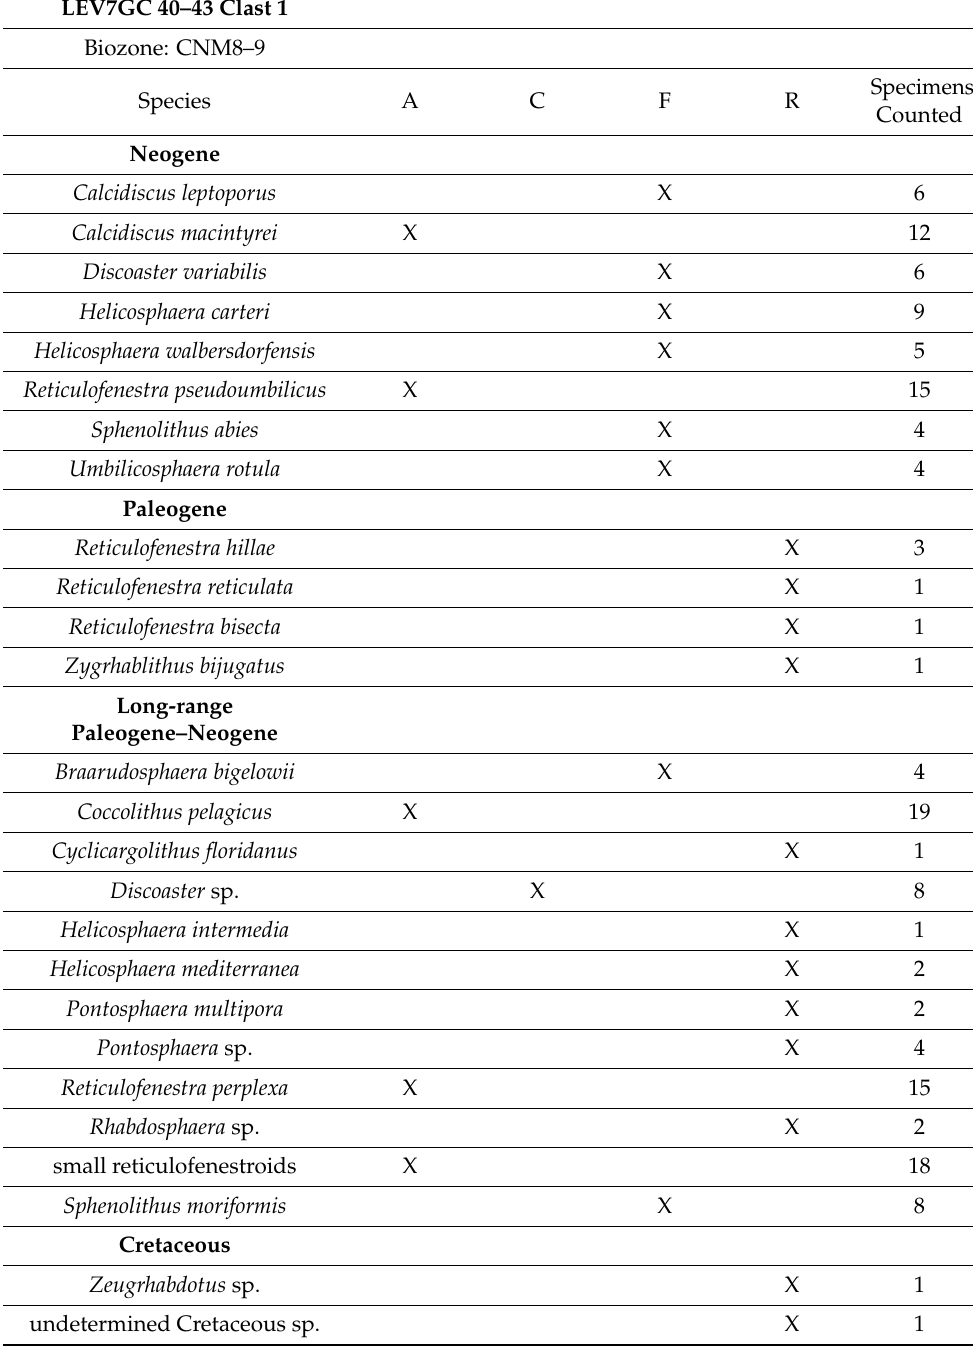
Table A31. Milano